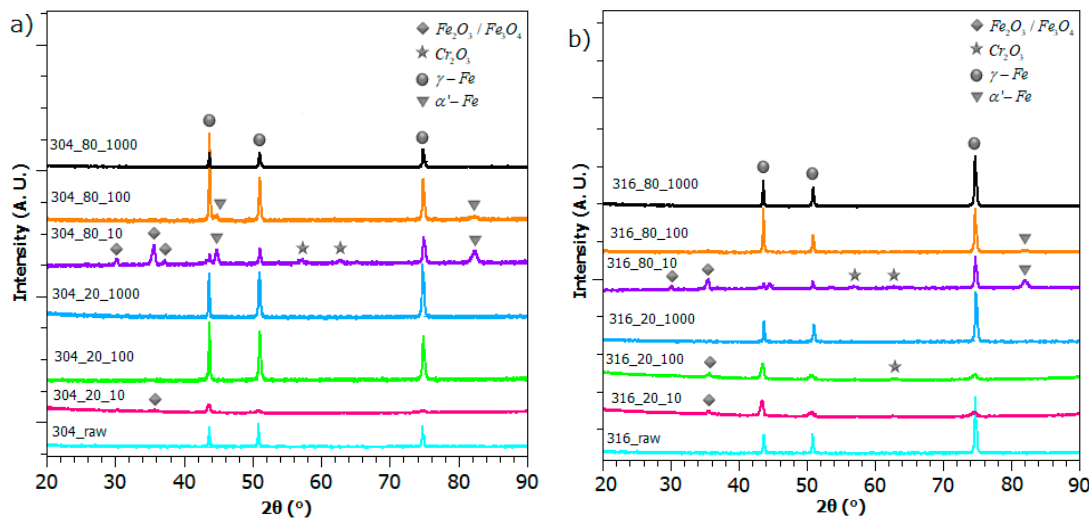
Figure 5. The XRD patterns of laser modified samples and untreated steel: ( a ) AISI 304; and ( b ) AISI 316 stainless steel.